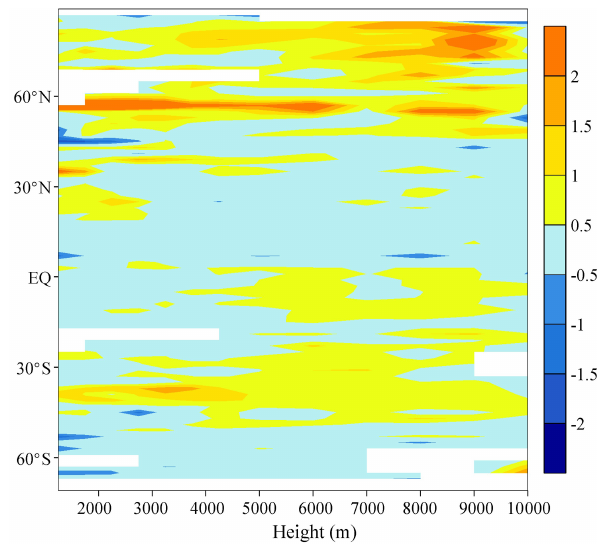
Figure 13. BIAS at different latitudes and heights against the HIPPO